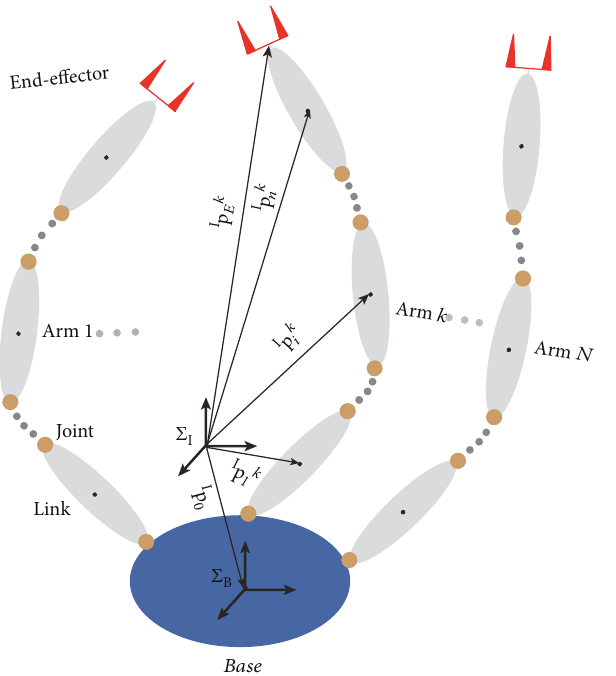
Figure 1: The model of a space-robot system. The system has N arms: only the 1 th , k th , and N th arms are shown. And each arm has n k